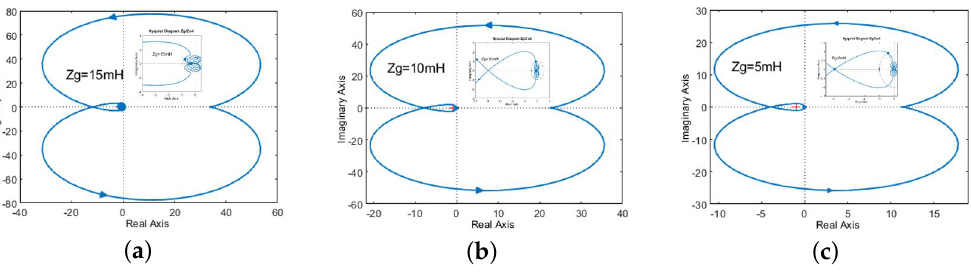
Figure 13. Impedance-based stability of proposed GTI by using Nyquist Plot ( a ) Nyquist plot of impedance ratio Z g 1 ( s ) / Z 4 o ( s ) . ( b ) Impedance ratio Z g 2 ( s ) / Z 4 o ( s ) . ( c ) Impedance ratio Z g 3 ( s ) / Z 4 o ( s ) .